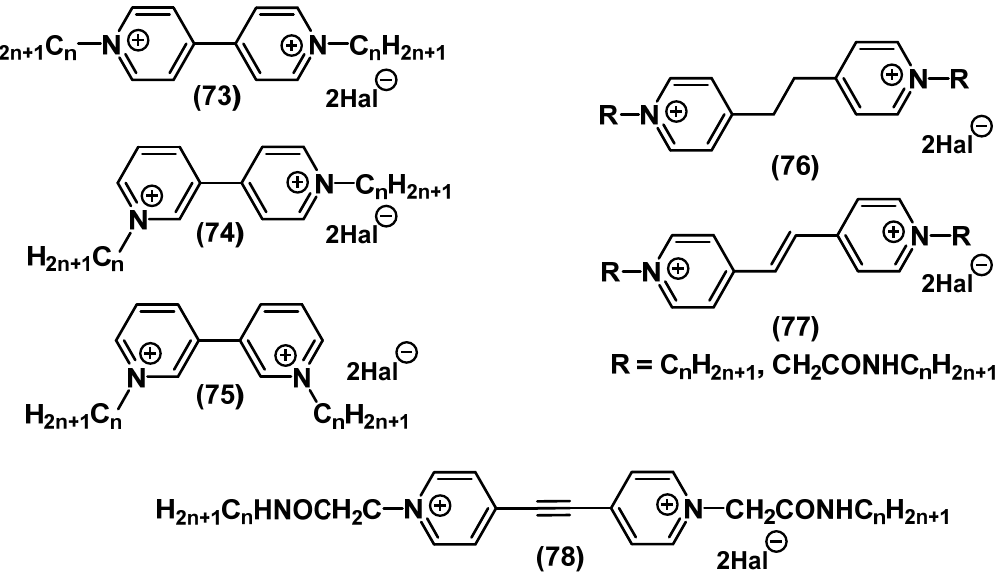
Figure 26. Pyridine-based bis-QACs without spacers and with alkyl spacers. In the work of Minbiole and colleagues, bispiridinium QAC derivatives of paraquats 73 - 75 and bis-QACs without a spacer between pyridinium heads were studied. The activity of meta- 75 and parameta-analogs 74 was more pronounced. Cyclovoltamperometric analysis showed the predisposi- tion of paraquats 73 to reversible oxidation-reduction processes and the for- mation of “superoxide”. This presumably increases the toxicity, while metaquats 75 and parametaquats 74 are not subject to this possibility and thus can be less toxic. In addition, given the high activity of parameta-derivatives 74 , this indicates the incoherence between the increase in the biocidal action of QACs and their redox capacity [116,117]. A study on the dependence of the activity on the rigidity of the structure for bispyridinium-QACs with al- kyl spacers with different saturations 76 - 78 showed ambiguous results. While this dependence was not observed for QACs with alkyl chains as tails, and the MIC values remained approximately at the same level, in the case of bis- QACs with amide bridges in the tails, a sharp decrease in the activity was observed upon increasing the structural rigidity. The authors showed that in such rigid structures, the bis-QAC activity decreased as the charged heads moved away from each other [118]. In the last few years, new biocidal pyridine-based bis-QACs containing an aromatic fragment in a spacer have been synthesized (Figure 27). Thus, bis-QACs with 1,4-dioxophenyl as spacer 79 were significantly more active than commercial QACs (BAC 1, CHG 7) [119–121]. Vereshchagin’s group studied the dependence of the activity of biocides on the size of the aromatic spacer of salts, as well as the location of the spacer relative to the charged pyridinium nitrogen 79 - 83 [122–126]. It was discovered that the QAC activity increased upon increasing the length of the aromatic spacer. The activity in- creased in the following order: mono- 79 < bi- 80 < terphenyl 82 [122,124]. It can be assumed that in such structures, the activity increases with an increase in the distance between the nitrogen atoms. It is worth noting that the optimal